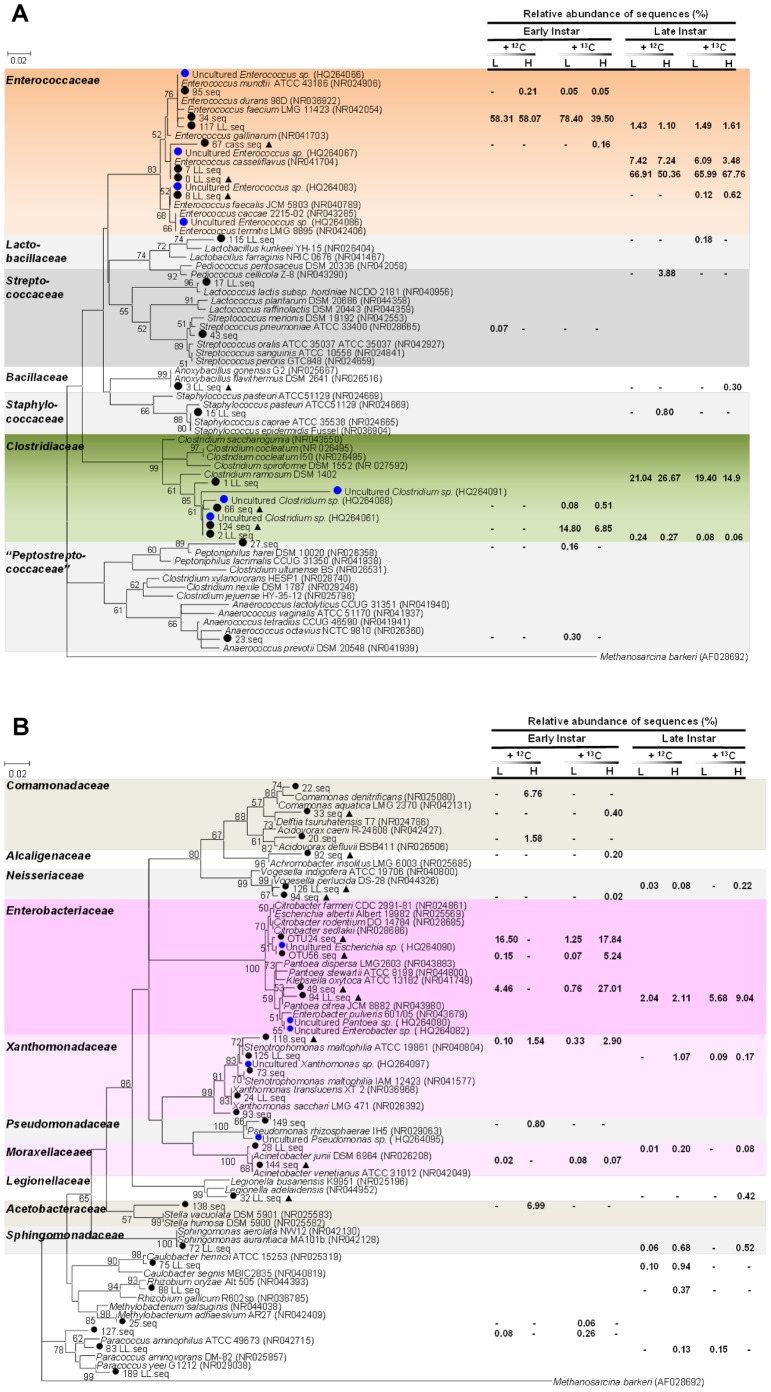
Phylogenetic analysis of (a) Firmicutes and (b) Proteobacteria identified from the gut microbiota of cotton leafworm.(A) Maximum Likelihood tree was derived from partial 16S rDNA sequence data for members of Firmicutes. (B) Neighbor-Joining tree was derived from partial 16S rDNA sequence data for members of Proteobacteria. Representative pyrosequences from this work and near full-length 16S rDNA sequences retrieved from previous clone-library-based studies are indicated by black circles (•) and blue circles, respectively. Labeled taxa are marked with triangles (▴). Reference sequences are downloaded from GenBank (accession numbers are in parentheses.). Methanosarcina barkeri (AF028692) is used as an outgroup. Family-level clusters are indicated by different colors. Bootstrap values (in percent) are based on 1000 replications. Bar represents 2% sequence divergence. Right section denotes percentage of representative bacterial 16S rRNA sequences in the total dataset of each sample. Abbreviations: +12C, native-glucose amendment; +13C, 13C-glucose amendment; L, light fractions; H, heavy fractions.